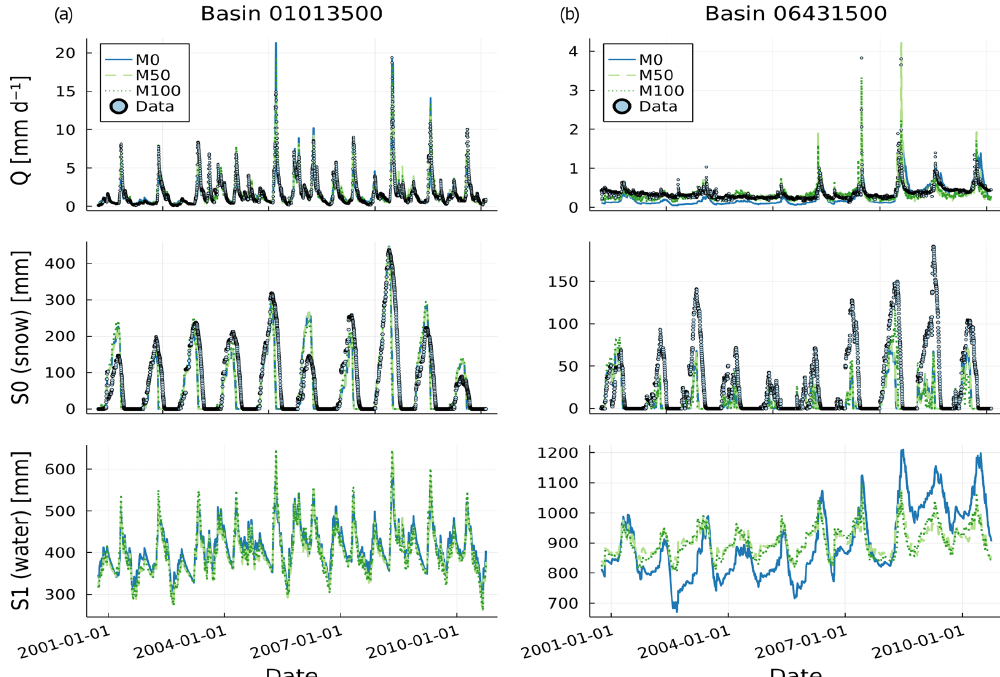
Figure 3. Time series of data and model predictions from models M0, M50 and M100 for discharge (top), snow storage (centre) and water storage (bottom; no data) for the test period in basin 1013500 (a) and in basin 6431500 (b) .